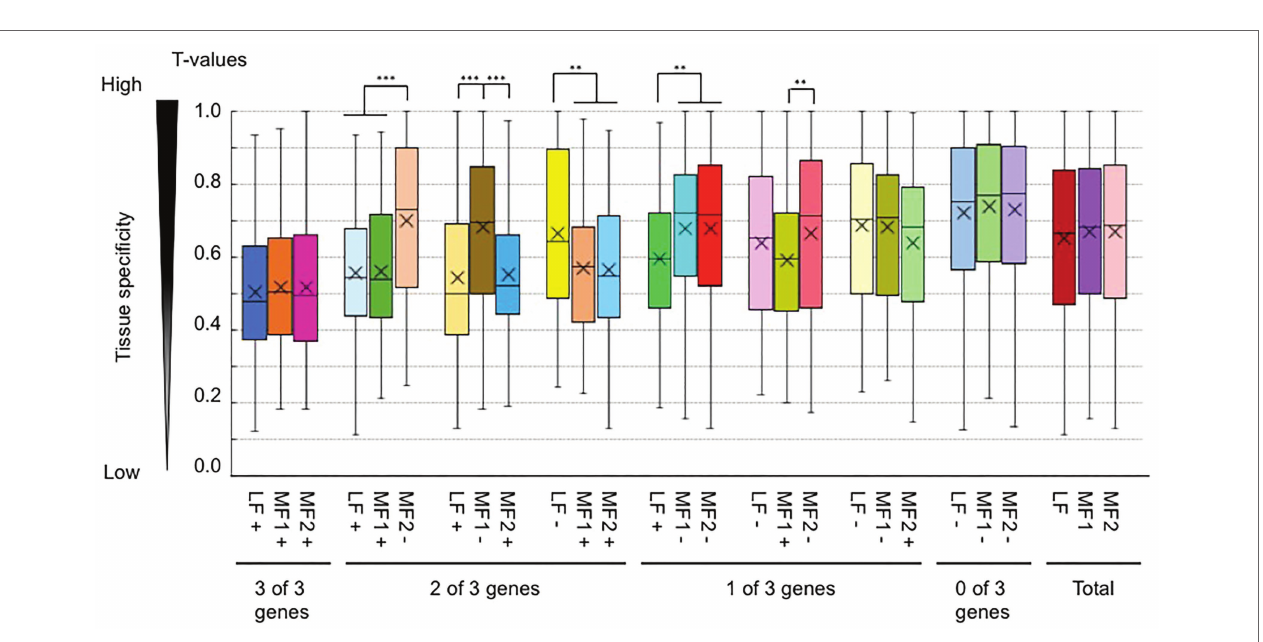
FIGURE 8 | Comparison of the tissue specificity of expression (a tissue specificity index, T -value) between paralogous pairs with and without H3K36me3 marks. Values are means ± standard error (s.e.) of FPKM. “+” and “ − ” represent the presence and absence of H3K4me3 marks, respectively. ** p < 0.01; *** p < 0.001 (Student t